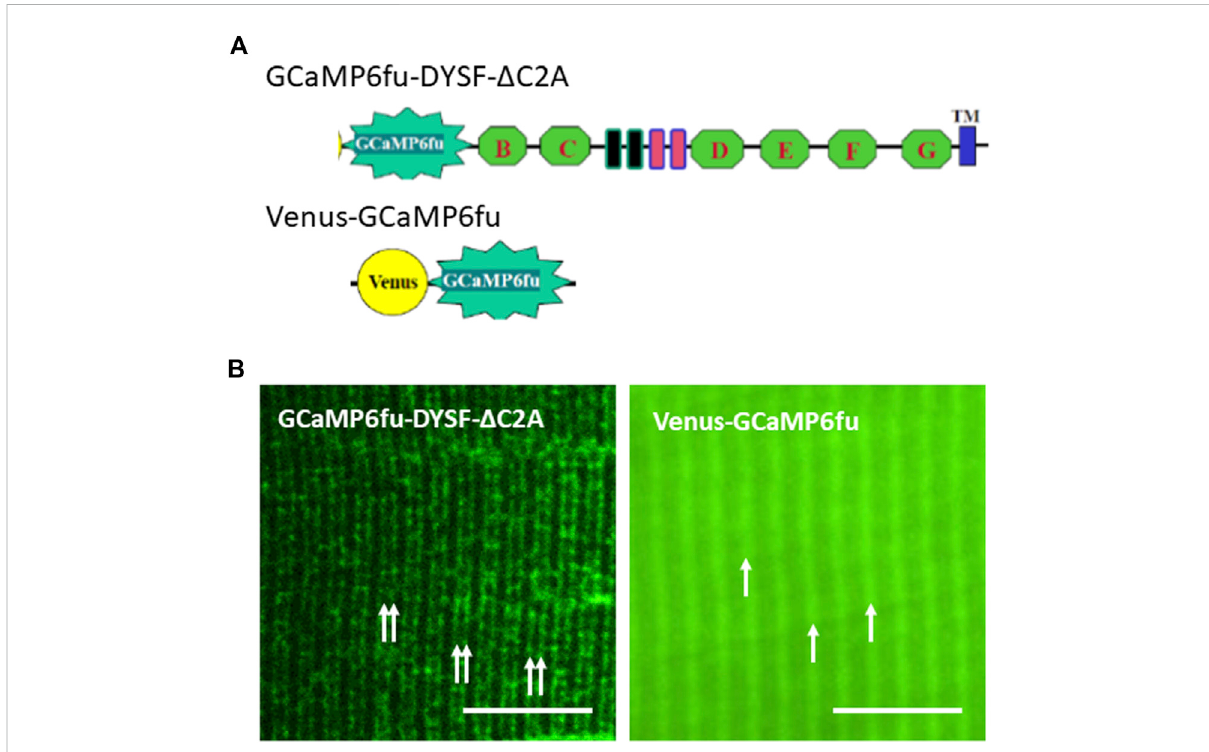
FIGURE 5 Distributions of GCaMP6f u and GCaMP6f u -DYSF- Δ C2A in sarcoplasm. (A) . Cartoon diagrams of chimeric structures, which include the CMV promoter, the GCaMP6f u reporter, and, for GCaMP6f u -DYSF- Δ C2A, the dysferlin ORF excluding most of the C2A domain (i.e., residues 108 – 2080) but including the remaining C2 domains B thought G (green hexagons), the Fer and DysF domains in the middle of the molecule (blue and pink outlined rectangles) and the transmembrane domain (blue rectangle near the C terminus; see Methods). (B) . Subcellular distribution of Venus- GCaMP6f u and GCaMP6f u -DYSF- Δ C2A in transfected A/J myo fi bers. Plasmids were electroporated into A/J myo fi bers and imaged under confocal optics 2 weeks later. Double arrows: transverse tubules at level of triad junctions, as reported (Kerr et al., 2013; Muriel et al., 2022); single arrows : Z-disks, as reported (Muriel et al., 2022). Bars, 10